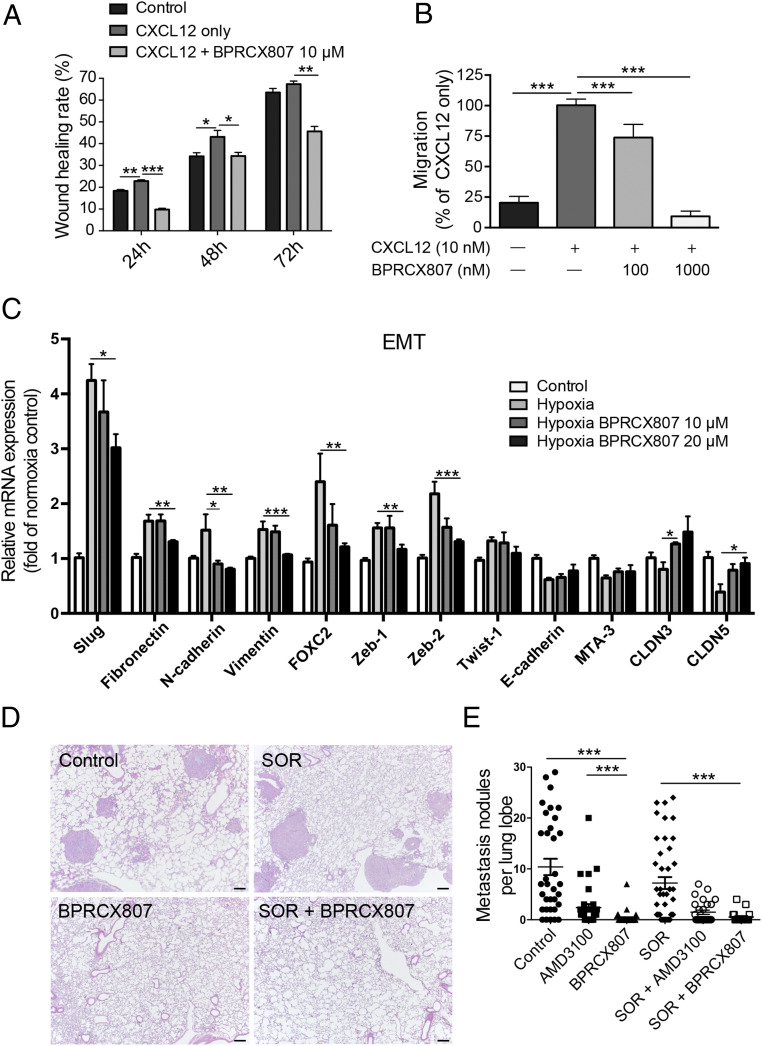
BPRCX807 suppresses metastatic progression of HCC. (A) Migration assay of HCA-1 cells incubated for 24, 48, and 72 h after treatment with CXCL12 (100 ng/mL) and BPRCX807 (10 μM) (n = 3). (B) CXCL12-induced HCA-1 chemotaxis was analyzed to measure the inhibitory activity (n = 3). (C) BPRCX807 inhibits the EMT phenotype of HCA-1 cells under hypoxic conditions (1% oxygen). The messenger RNA levels of EMT regulators (Slug, FOXC2, Zeb-1, Zeb-2, and Twist-1), epithelial markers (E-cadherin, MTA-3, CLDN3, and CLDN5), and mesenchymal markers (vimentin, fibronectin, and N-cadherin) were determined by qRT-PCR 24 h (EMT regulators and mesenchymal markers) or 48 h (epithelial markers) after treatment with BPRCX807 at different doses (n = 4 to 12). (D) Representative hematoxylin/eosin staining images showing metastatic tumor nodules in the lung. (Scale bars, 200 μm.) (E) The number of spontaneously occurring lung metastatic nodules in orthotopic HCA-1 HCC models was reduced in mice treated with AMD3100 or BPRCX807 (n = 19 to 34). The data are the mean value ± SEM. *P < 0.05, **P < 0.01, and ***P < 0.001.